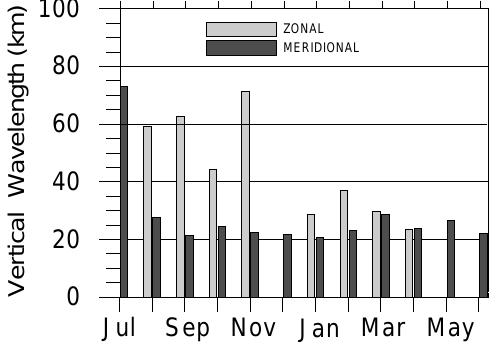
Fig. 7. Vertical wavelength of diurnal oscillation for zonal and meridional components from July 2004 to June 2005.